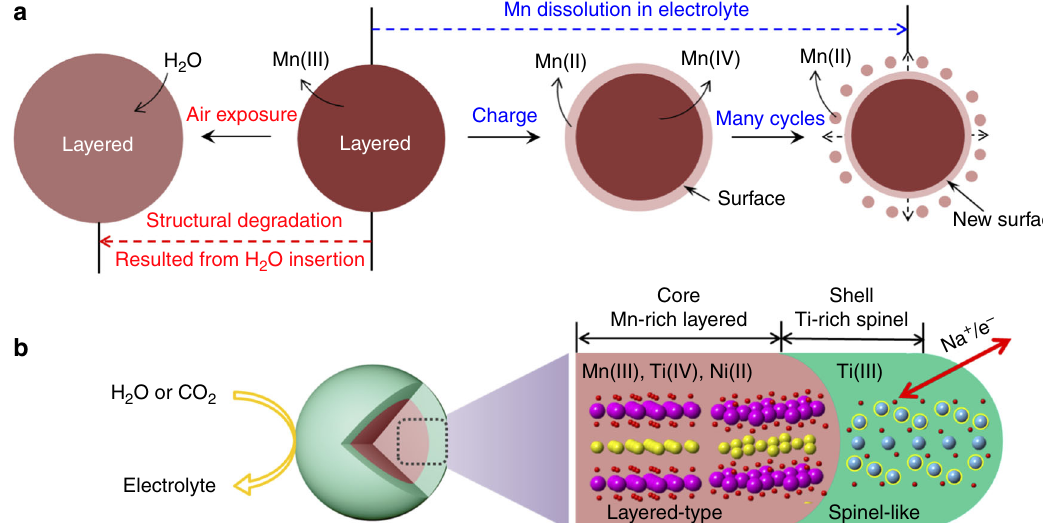
Fig. 4 Diminished performance mechanism of the NM samples and protective mechanism of the NMTN samples. a Structural degradation of the NM samples subjected to attack from air ( red dotted left arrow ) and electrolyte ( blue dotted right arrow ). b 3D structural model of the NMTN samples composed of a Ti-rich spinel-like interface ( green shell ) and Mn-rich layered bulk ( brown core ). The layered bulk ( brown core ) is composed of P2 ( left ) and O ′ 3 ( right ) phases. The Ti-rich spinel-like interface not only protects the bulk NMTN samples against atmospheric and electrochemical corrosion but also